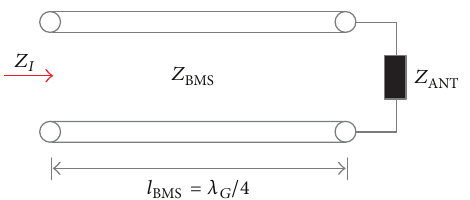
Figure 5: Electrical equivalent circuit—the input impedance of the antenna is matched to the system impedance using matching microstrip line section as a quarter wavelength transformer.